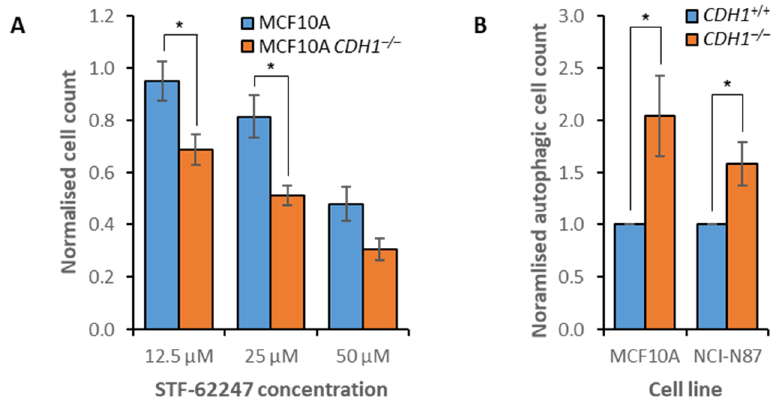
Figure 4. Differences in autophagy between CDH1 +/+ and CDH1 − / − cells. ( A ) MCF10A and MCF10A CDH1 − / − cells were drugged with STF-62247, then viability was quantified through nuclei counting, and normalization to vehicle controls. Although a nine-point serial dilution was assessed, only the three consecutive compound concentrations that exhibited the greatest difference in viability between CDH1 +/+ and CDH1 − / − cells are depicted. ( B ) MCF10A and NCI-N87 isogenic cell lines were treated with 0.2% DMSO, then autophagic vacuoles were stained and quantified. Average values were calculated from three (MCF10A) or five (NCI-N87) biological replicates. Error bars depict +/ −